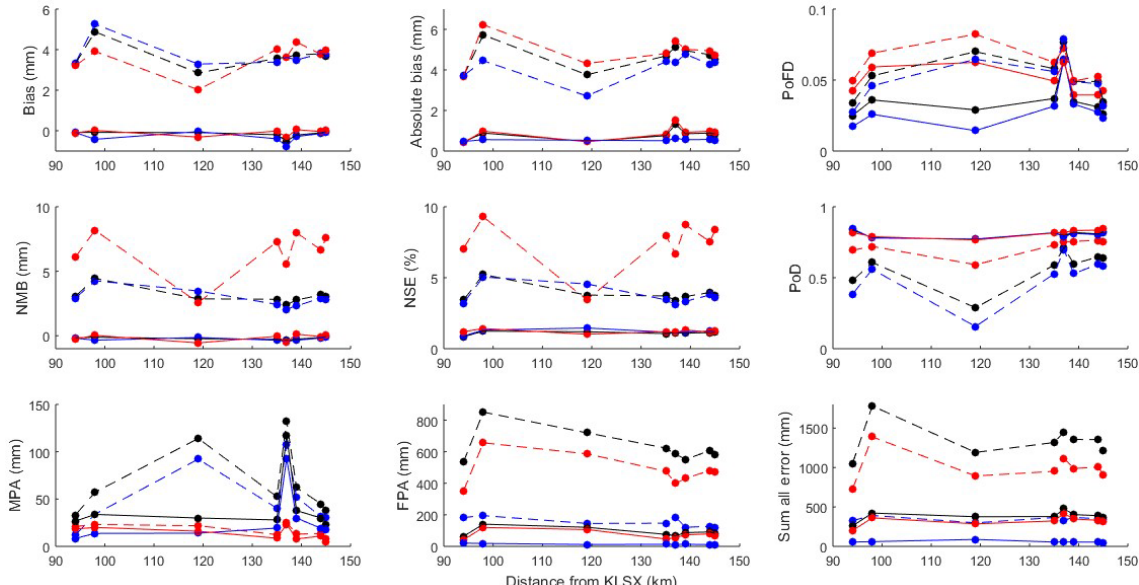
Figure 5. Values of analyses from the St. Louis radar. Dashed lines and points represent the analyses of the worst-performing algorithm ( R (ZDR,KDP)), while the solid lines and points represent the analyses of the best-performing algorithm ( R ( Z ,ZDR)). Red, blue, and black colors represent analyses conducted during the warm season, cool season, and overall, respectively.